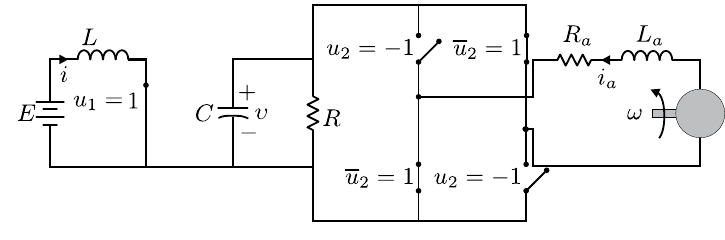
Figure 6. Equivalent circuit when u 1 = 1 and u 2 = −